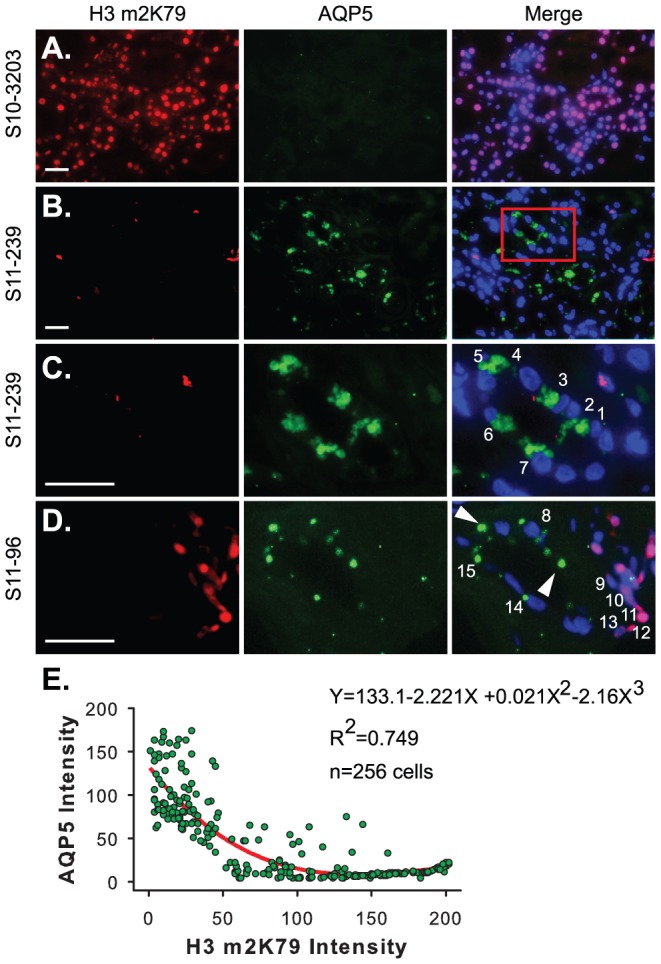
AQP5 expression is inversely correlated with H3m2K79 in DN.(A–D) Representative IF images of kidney biopsies from a patient with MCD showing strong H3m2K79 and undetectable AQP5 (A) and from two patients with DN showing significantly reduced H3m2K79 in most of the cells with some of them robustly expressing AQP5 (B–D). The boxed area in B was amplified and shown in C. The presence of large discrete foci was exclusively used to score AQP5 positive staining. If an AQP5+ cell has a clear DAPI-stained nucleus as shown in C and D, they are numbered. (E) The pixel intensities of AQP5 and H3m2K79 measured simultaneously, using ImageJ64. Arrowheads in D indicate ignored AQP5+ spots due to absence of a nucleus showing the status of H3m2K79. Scale bar: 50 µM.